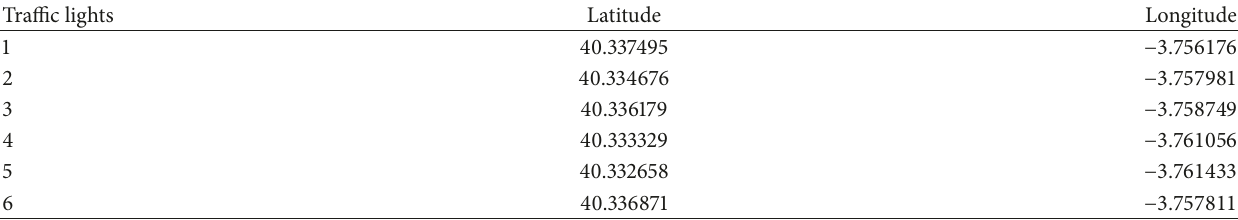
Table 2: Traffic lights locations.